Question: Provide a one-line summary of what is displayed.
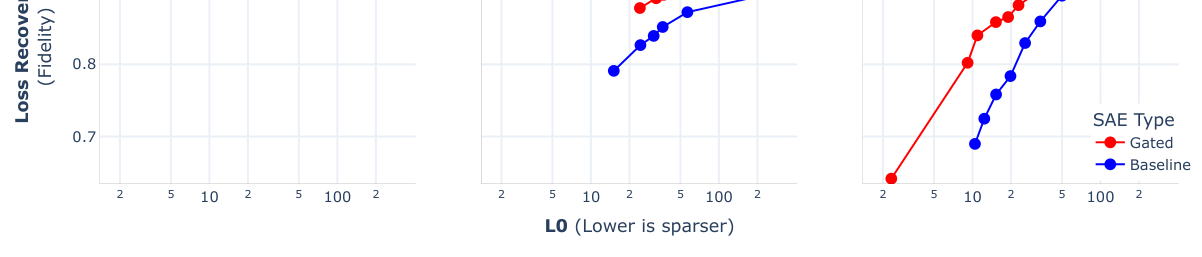
Answer: | The performance of Gated SAEs compared to the baseline SAE at Layer 20 in Gemma-7B (log-scale axes from L0=2 to L0=200). The SAEs are trained with equal compute, since the baseline SAEs have 50% more learned features (Section 4.1). This performance improvement holds in layers throughout GELU-1L, Pythia-2.8B and Gemma-7B (Appendix B). Full detail in Table 2 and 4.